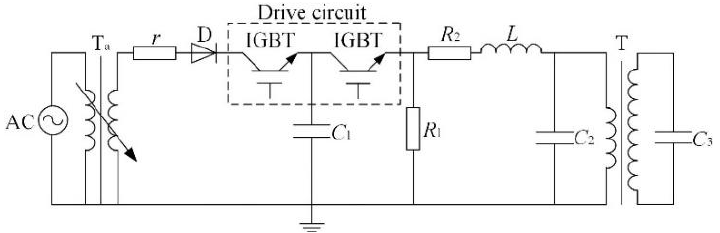
Figure 14. General circuit to generate the SI voltage based on the transformer.